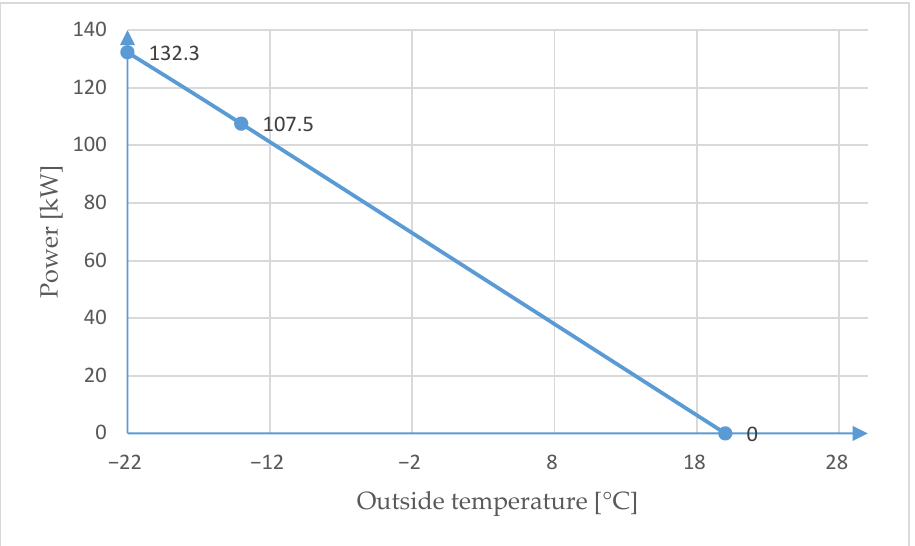
Figure 5. Determination of the bivalent point on the power demand cover diagram.